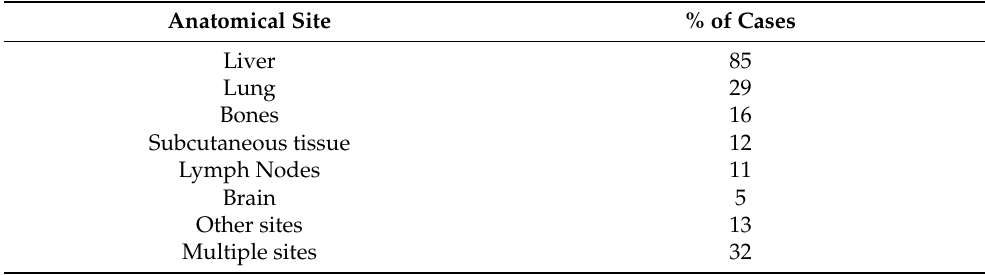
Figure 1. Overview of key facts in uveal melanoma, the most common intraocular primary malignant tumour in adults. Different risk factors are associated with the development of uveal melanoma. The choroid is the most frequent intraocular site of uveal melanoma development, which is detected in routine ophthalmological exams in asymptomatic patients. However, the majority of uveal melanoma patients present with symptoms, such as blurred vision or photopsia. Metastases, especially to the liver, occur in nearly 50% of patients during the first 10 years after diagnosis, but constitute a presenting symptom in only a small fraction of patients (<2%). In the carcinogenic process of uveal melanoma, several tumour-initiating and tumour-promoting mutations have already been identified and characterized. Uveal melanoma patients with mutations in BAP1 (highlighted in red) have been demonstrated to have the worst outcome, while patients with EIF1AX (highlighted in green) have a better prognosis and patients with SF3B1/SRSF2 (highlighted in orange) have an intermediate prognosis. Diagram generated in line with previous literature [1–3,9,22,25–27,36–40] (Diagram created with BioRender.com, accessed on 15 December 2021). Table 1. Most frequent anatomic sites afflicted by metastases in uveal melanoma. The estimation of organ involvement was based on the compilation of the data from 1092 patients extracted from 5 relevant previously published studies [24,41–45] . Relative percentages are variable depending on the cohort studied. However, in all studies, the liver is the preferential site of UM metastization. Anatomical Site